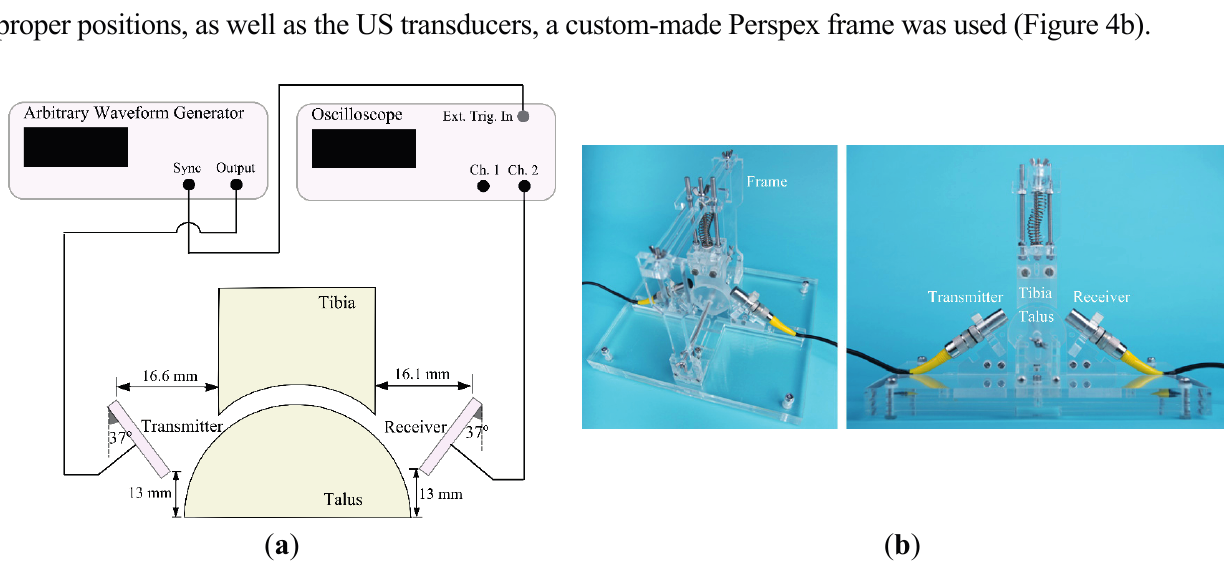
Figure 4. ( a ) Schematic presentation of the experimental setup; ( b ) Perspex frame